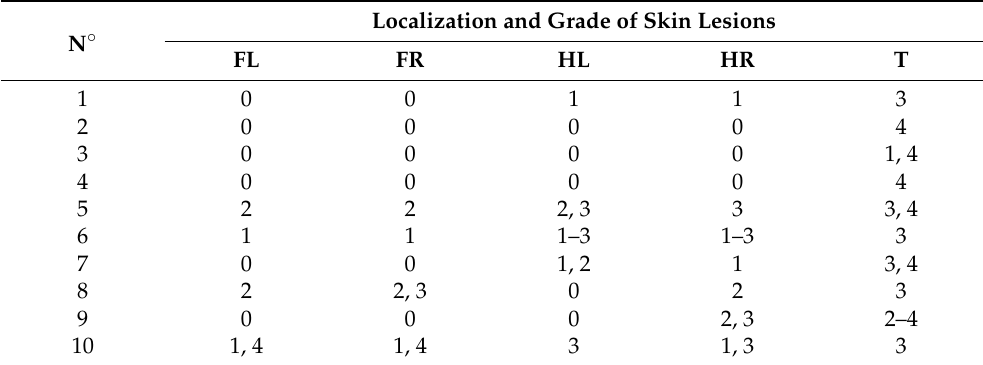
Table 2. Localization and grade of skin lesions in coypus ( Myocastor coypus ) examined. N°